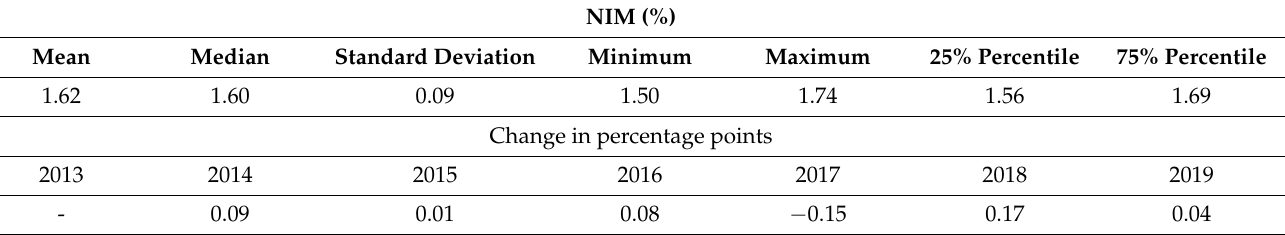
Table 6. NIM of Lithuanian banking sector in the period of 2013–2019. NIM (%) Mean Median